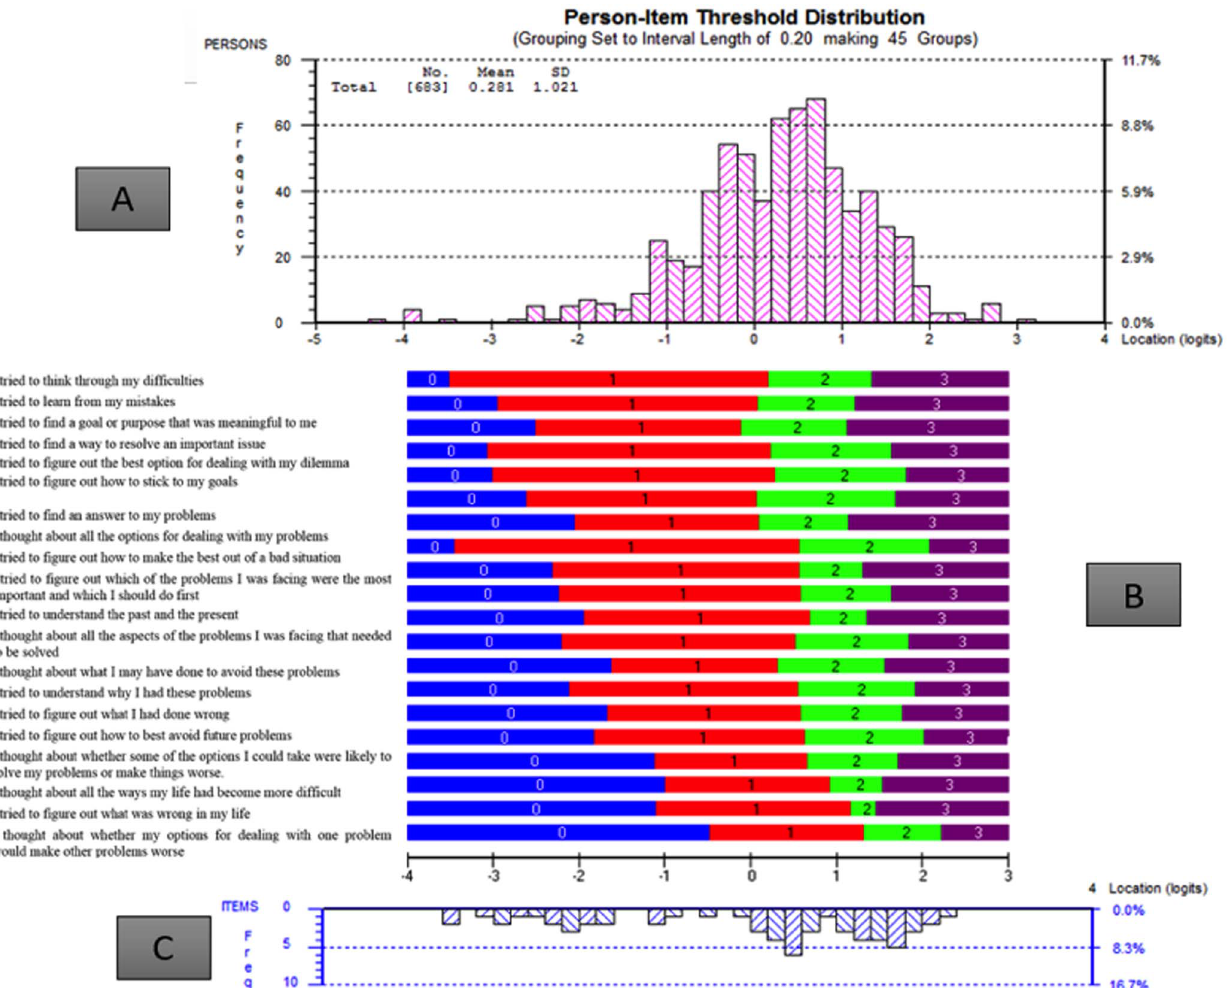
Figure 2. Summary of targeting to the sample of 20 items included in the Analytical Rumination Questionnaire. A. Distribution of items across the measurement continuum in the prototype analytical rumination questionnaire (ARQ). B. Item map showing expected score to each item, with items shown in order of difficulty. C. The location of the 20 items, relative to each other, on an interval scale.